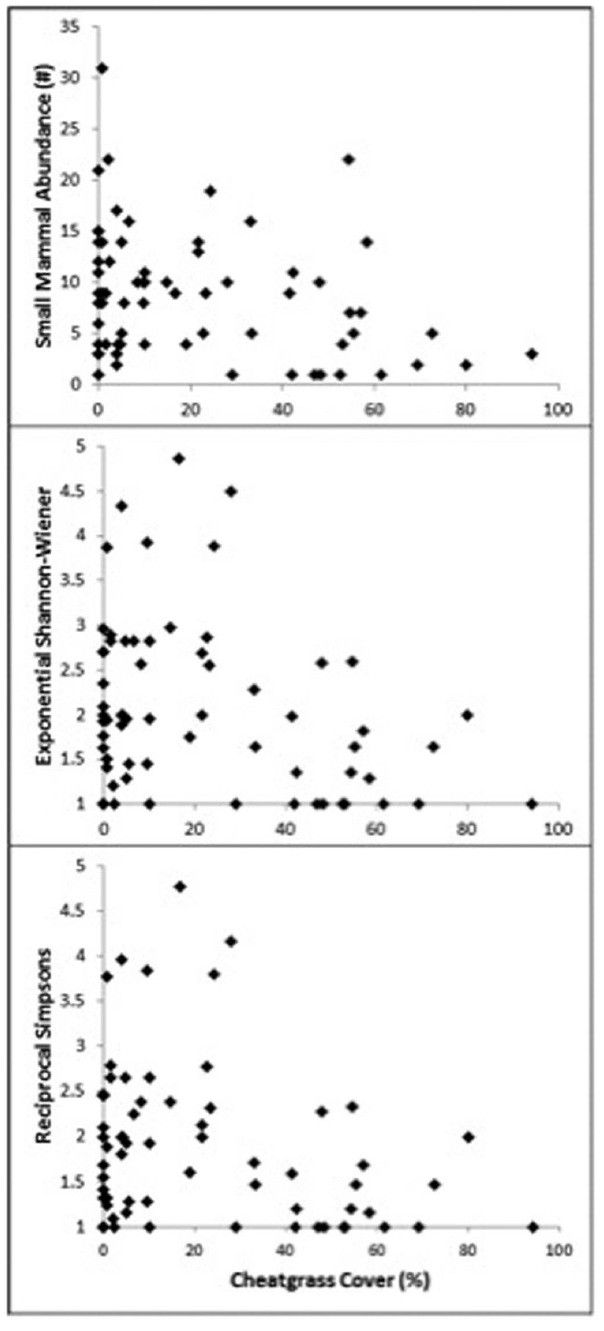
Figure 2. Cheatgrass and the Small-Mammal Community. Abundance (top), Exponential Shannon-Wiener index (middle), and Reciprocal Simpson’s index (bottom) for small-mammal assemblages at 66 sites with varying cheatgrass ( Bromus tectorum ) cover in the Great Basin Desert, Utah, 2011–2012.